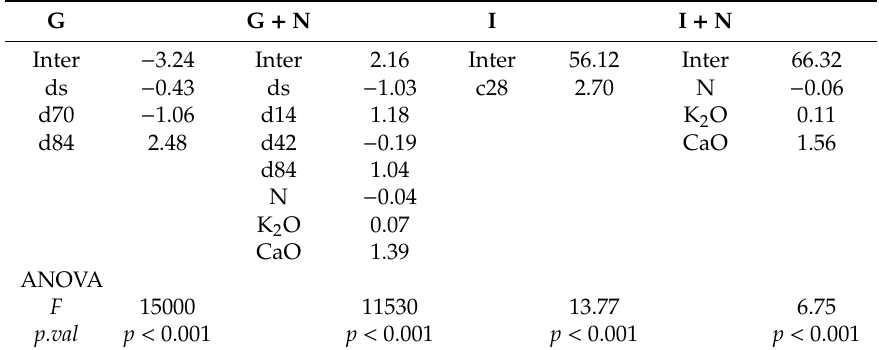
Table 8. Modelling of the Tines variety final growth (d98) based on development stage and applied